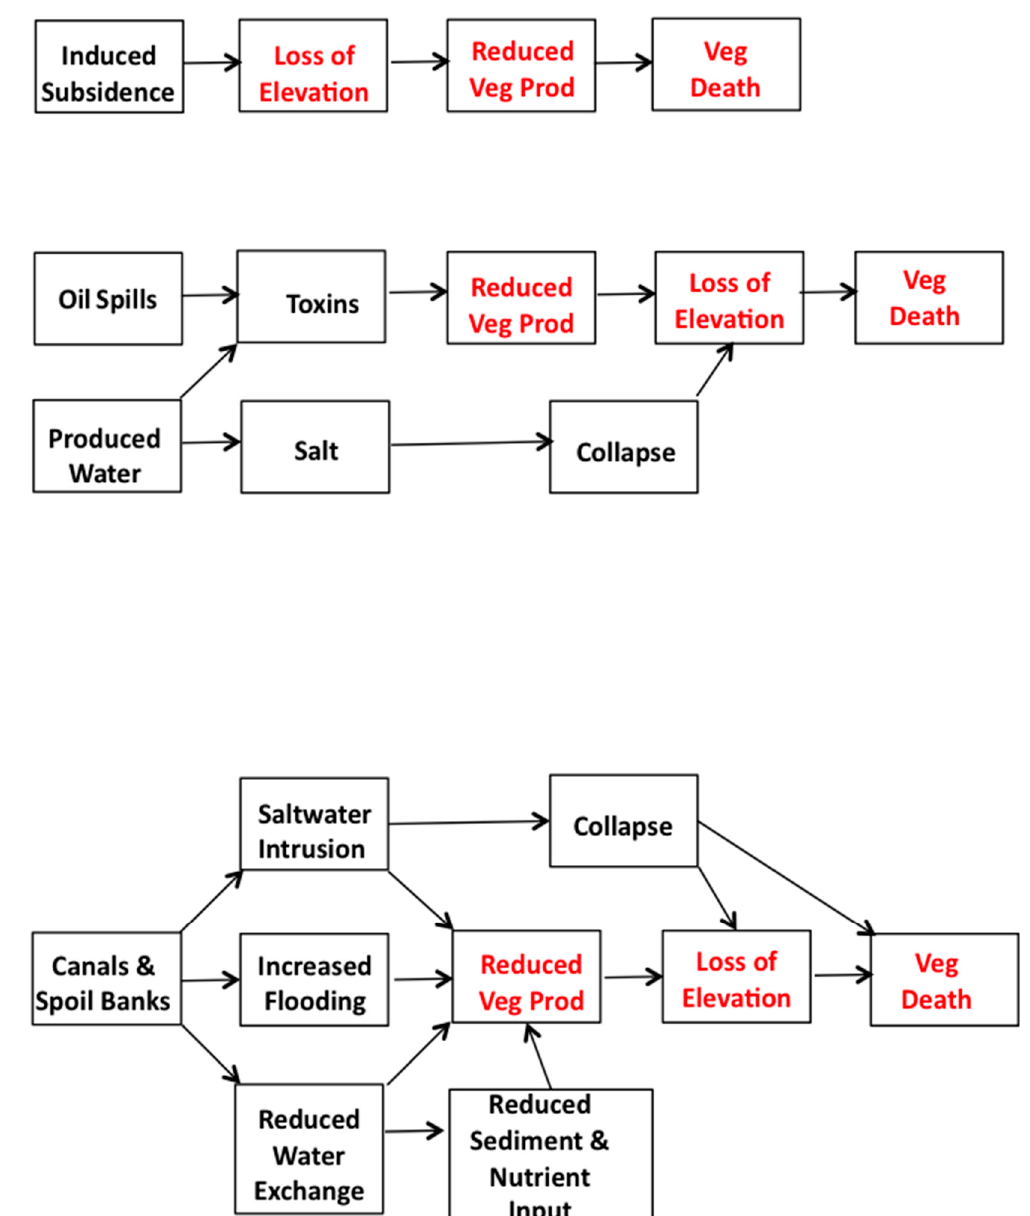
Figure 16. Diagram showing the three general types of impacts from oil and gas activity-induced subsidence, toxicity effects, and altered surface hydrology due to canals and spoil banks. The impacts of these activities are shown separately, and impacts shown in red are common to all three activities. As reduced vegetation productivity, loss of elevation, and vegetation death can result from all three activities, there are pervasive cumulative and indirect impacts that result in overall greater impacts on coastal ecosystems, especially, that would result from the impacts acting separately.